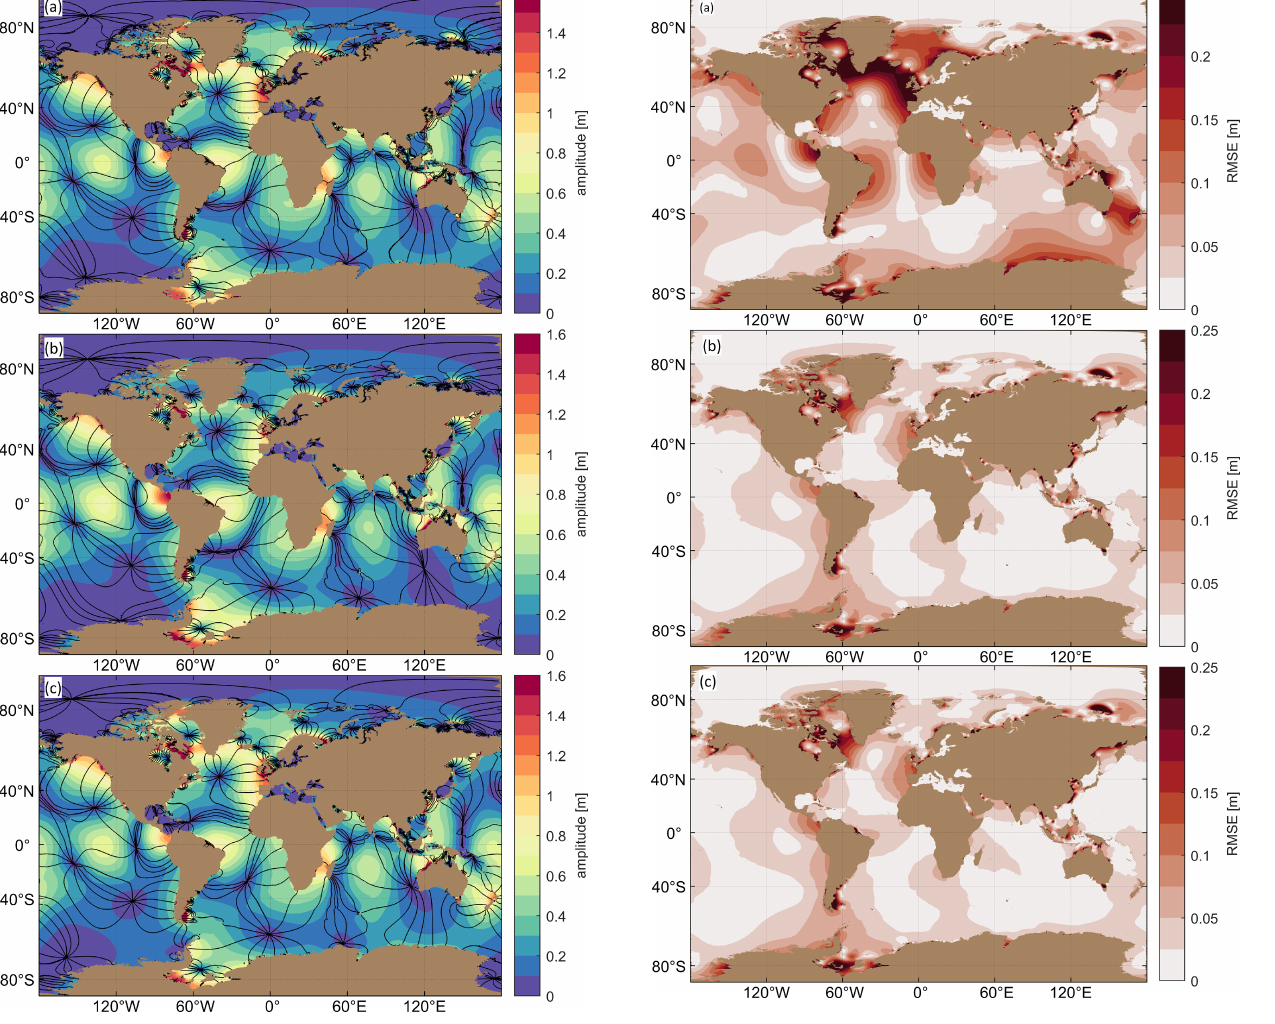
Figure 5. Global M 2 tidal amplitude and phase (cotidal lines are drawn in 30 ◦ increments) plots for (a) TPXO9-Atlas, (b) ADCIRC v54 on the Ref mesh, and (c) ADCIRC v55 upgrade on the Ref mesh.